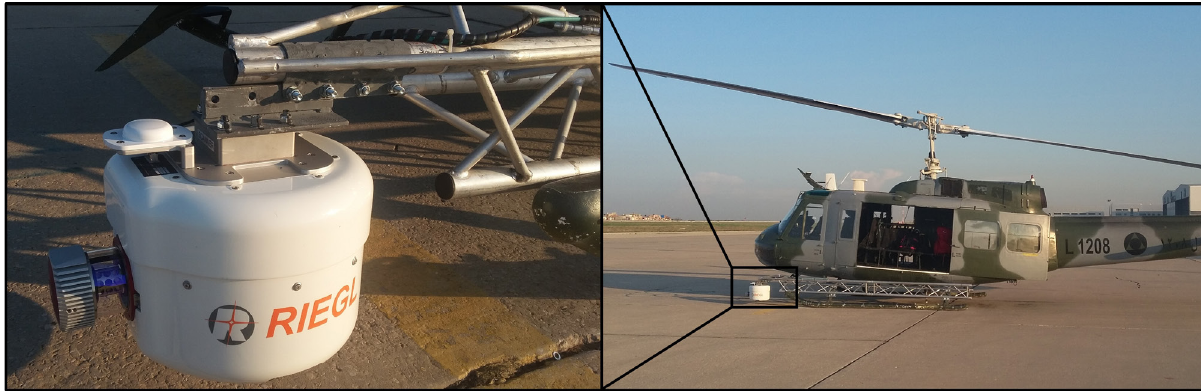
Figure 2: Self-made construction to mount the Riegl VP-1 POD on a Bell UH-1D helicopter of the Lebanese Army.